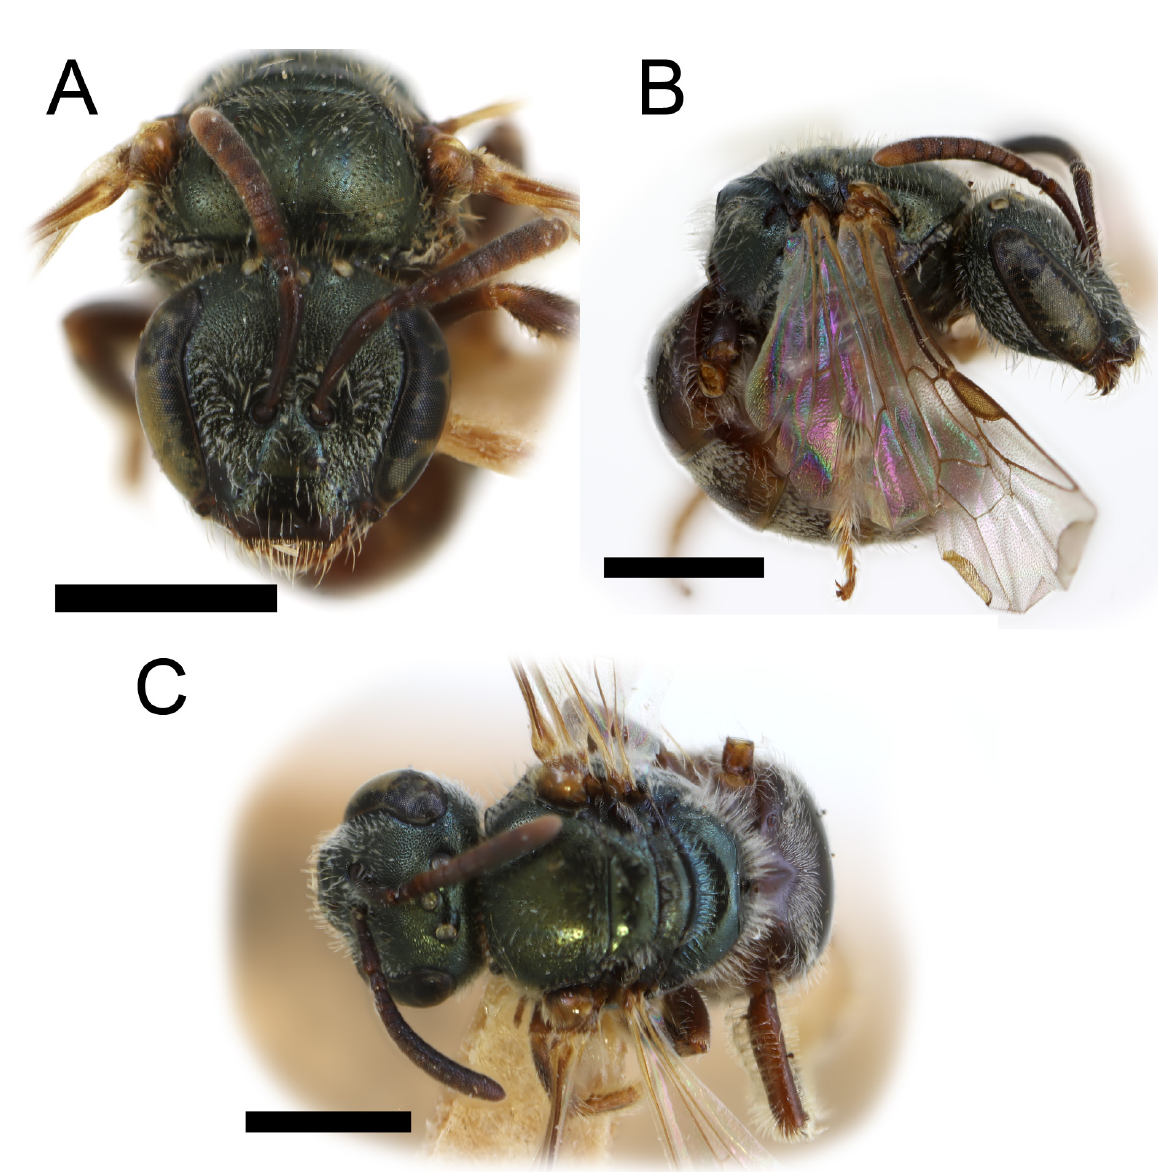
Fig. 6. Lasioglossum amona sp. nov., ♀. A . Face. B . Lateral habitus. C . Dorsal habitus. Scale bars = 1